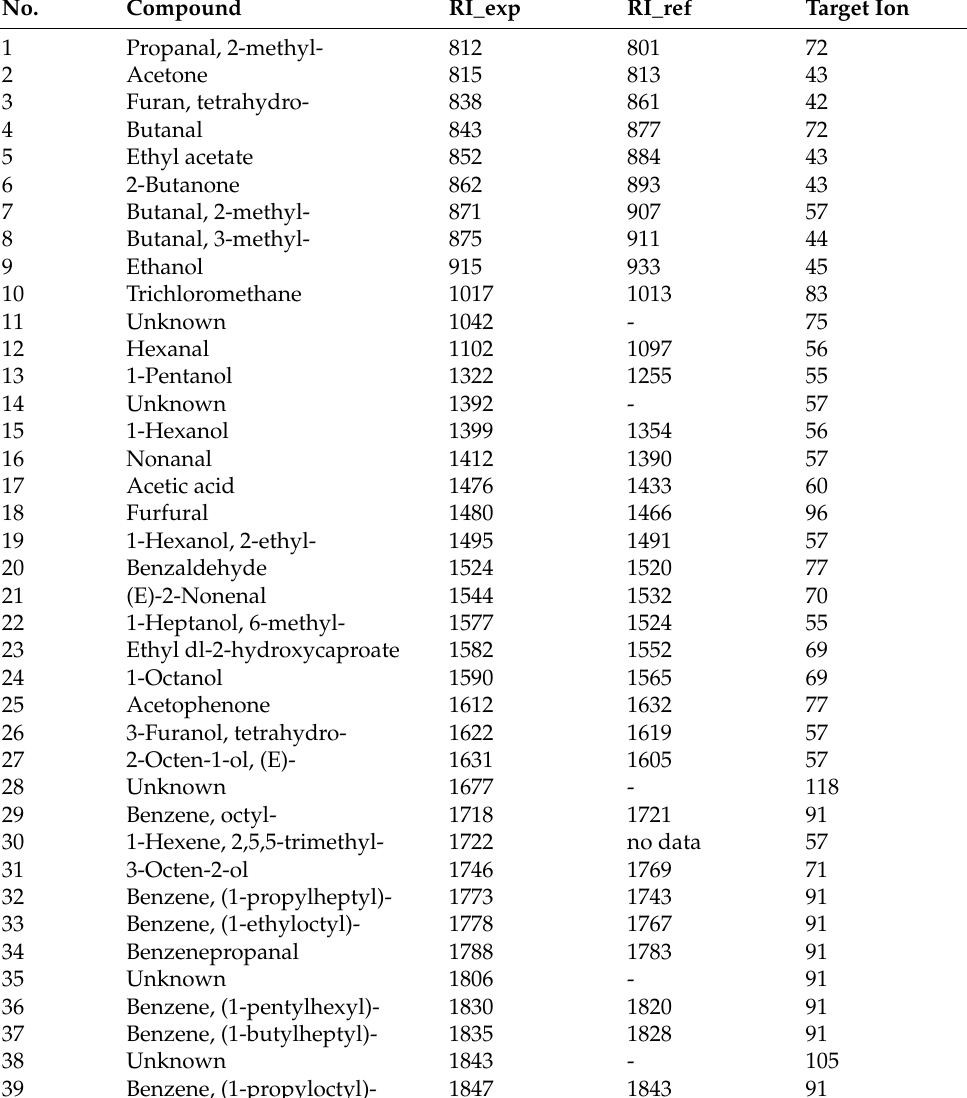
Table 3. Volatile compounds in white and brown rice